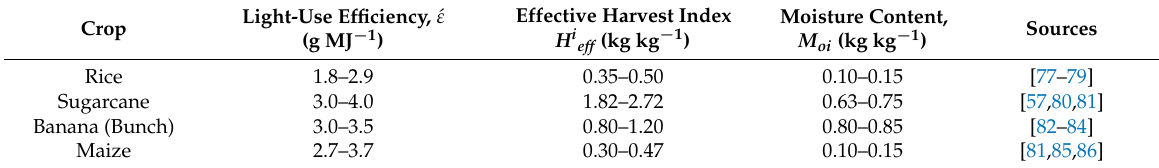
Table 2. Crop biomass parameters ranges for